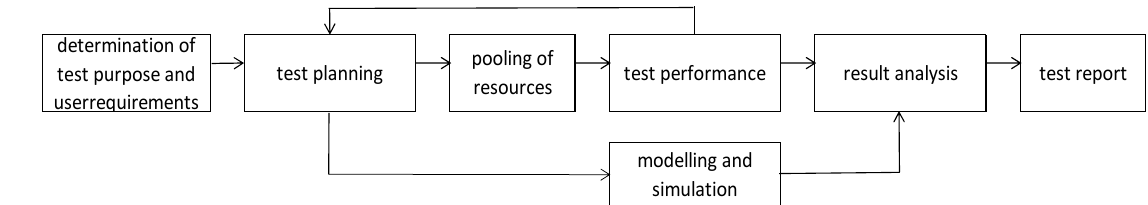
Figure 2. Scheme for the research and testing process.